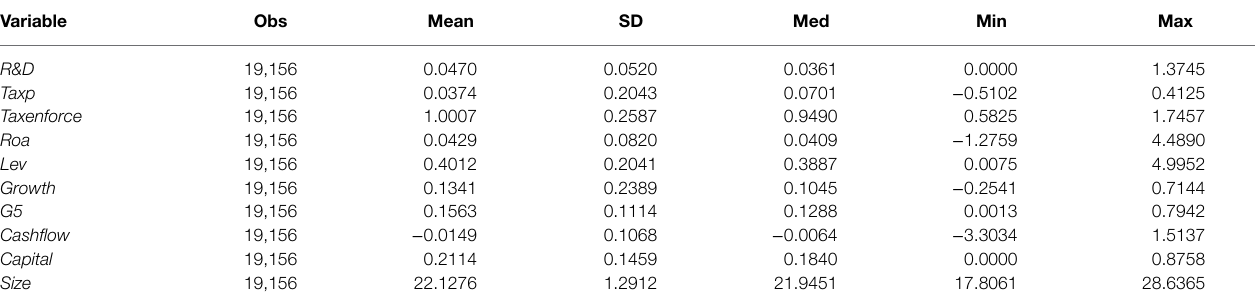
TABLE 2 | Descriptive statistics.